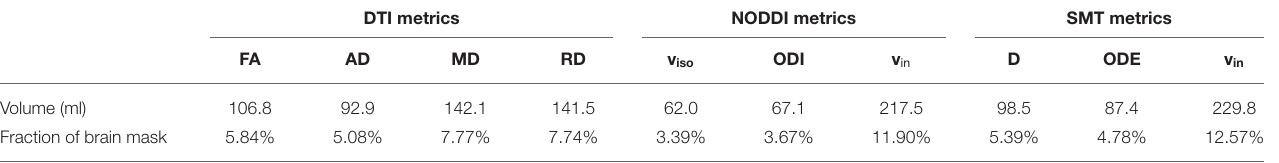
TABLE 3 | Volume of tissue in MNI space exhibiting statistically significant differences between patients and controls for all MRI metrics (DTI, NODDI, and SMT).